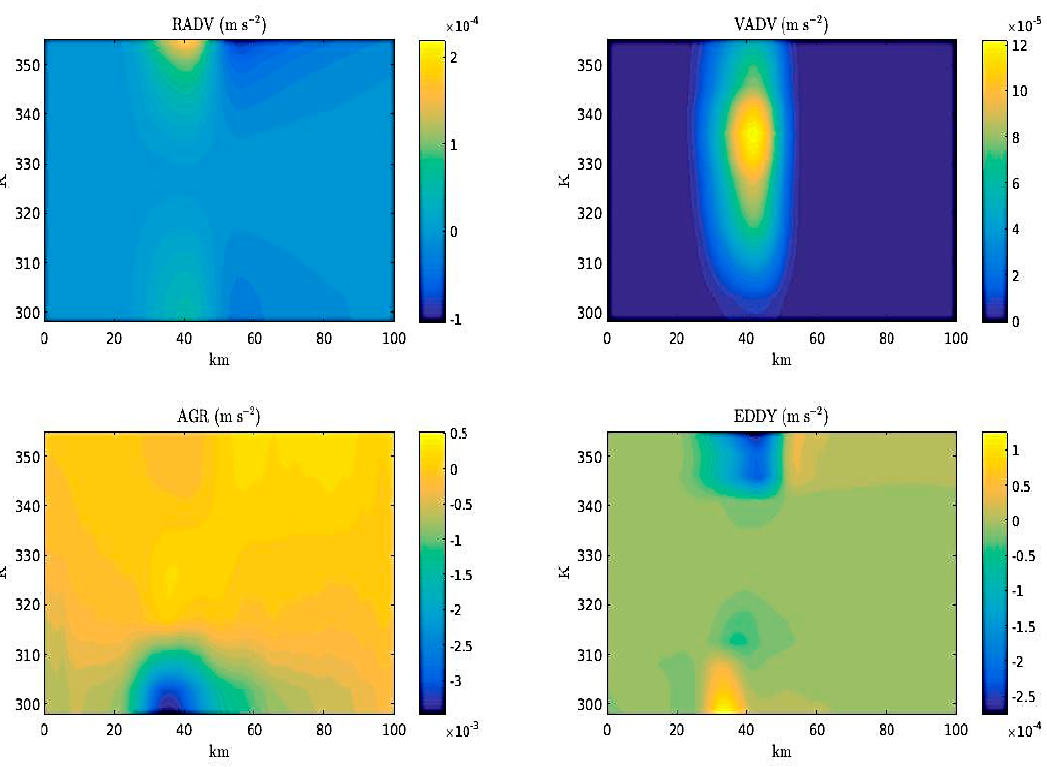
Figure 11. Azimuthal mean radial velocity budget at (cid:1872) = 4 h . (cid:1844)(cid:1827)(cid:1830)(cid:1848) corresponds to the radial advection of azimuthal mean radial velocity by the mean flow. (cid:1848)(cid:1827)(cid:1830)(cid:1848) corresponds to the vertical advection of azimuthal mean radial radial velocity by the mean flow. (cid:1827)(cid:1833)(cid:1844) corresponds to the agradient force. (cid:1831)(cid:1830)(cid:1830)(cid:1851) corresponds to the summation of all eddy terms as given in Equation (20).